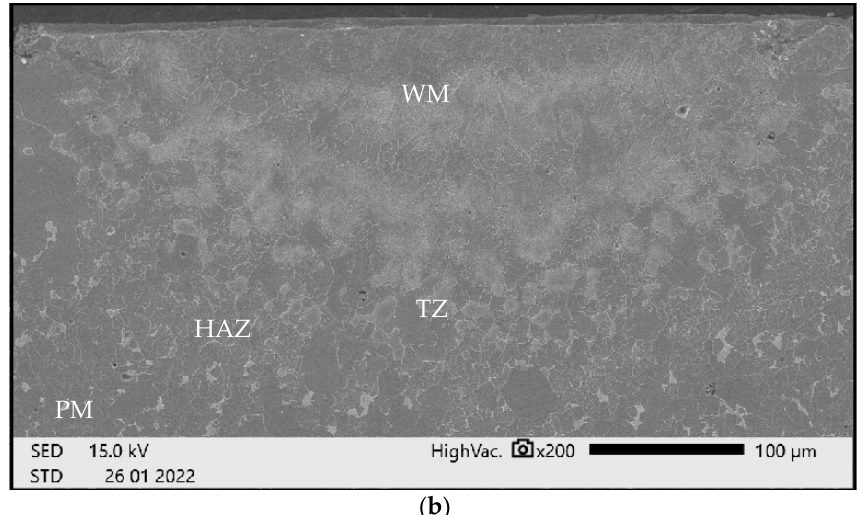
Figure 22. Sample no 2 reached with 50 Hz acoustic vibration delivered parallelly: ( a ) Metallography and ( b ) SEM; PM—parent metal, HAZ—heat affected zone, TZ—transition zone, WM—weld metal.